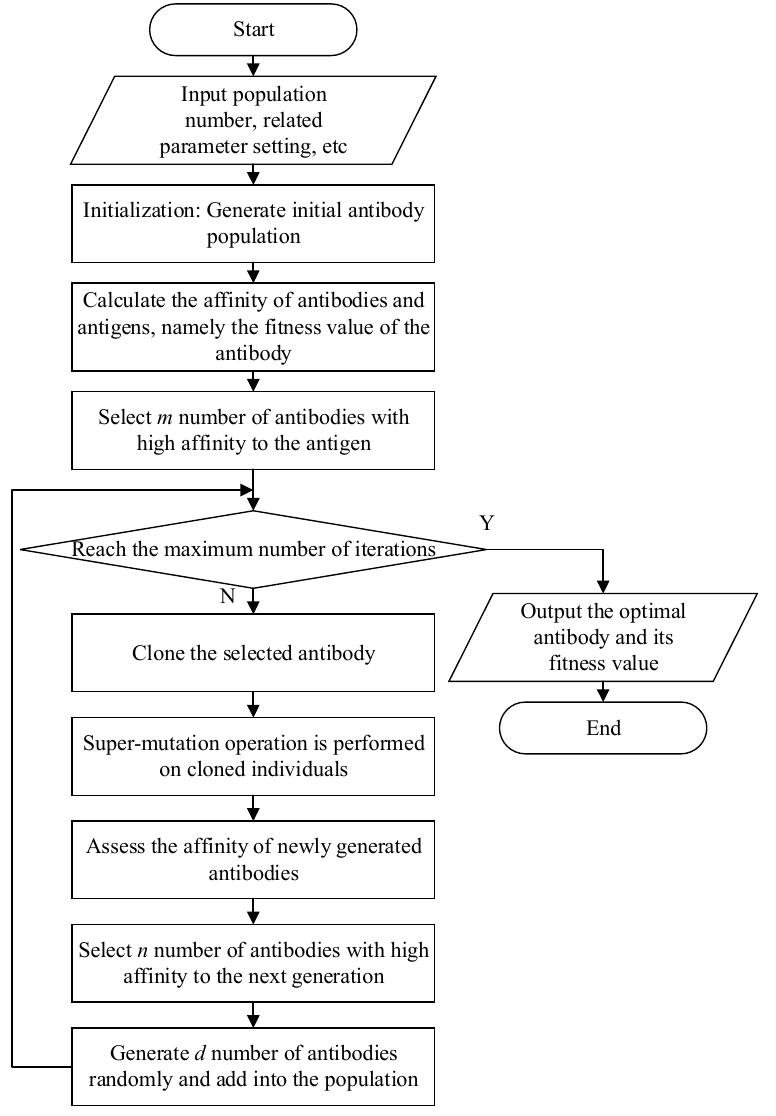
Figure 2. Flow chart of CSA.